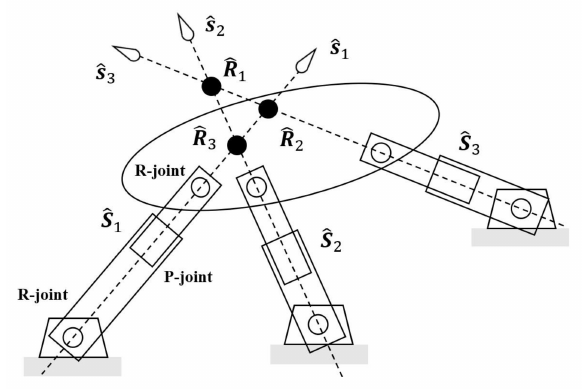
Figure 2. A planar parallel mechanism.